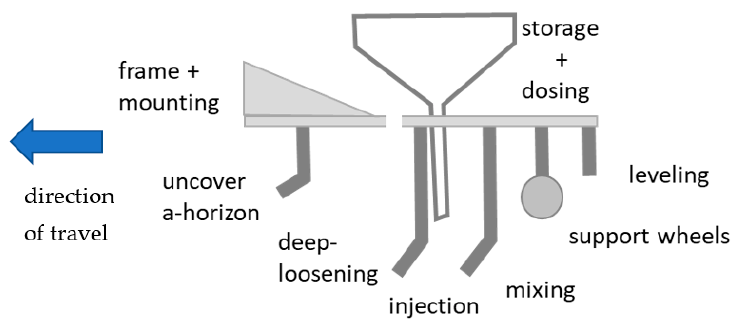
Figure 2. Phases of the Soil 3 melioration process and selected photos of the technology from the preliminary tests for tool selection and design.